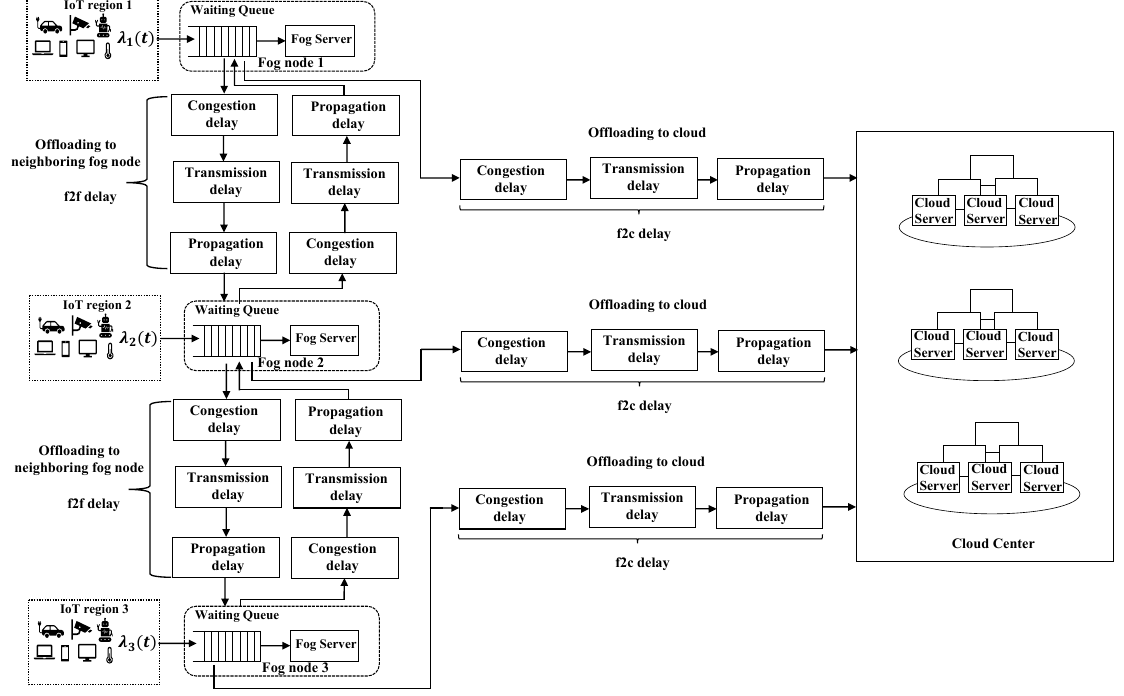
Figure 2. Flow chart showing the processes in the IoT-fog-cloud system.